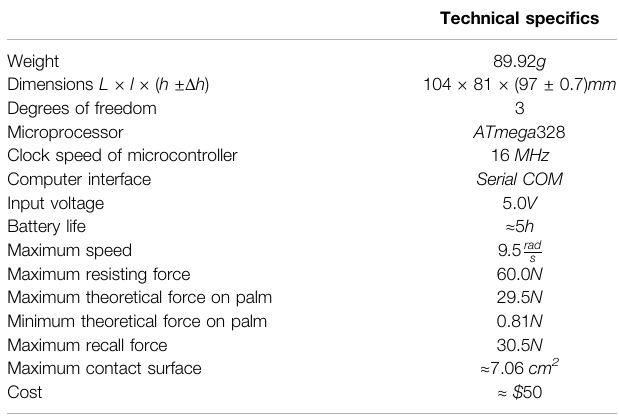
TABLE 2 | Haptic palm device prototype; main hardware/software details and technical speci fi cations. The dimensions of device are measured without the glove, and the value of Δ h is equal to the capability to extend and shorten the rigid link F with respect to the G